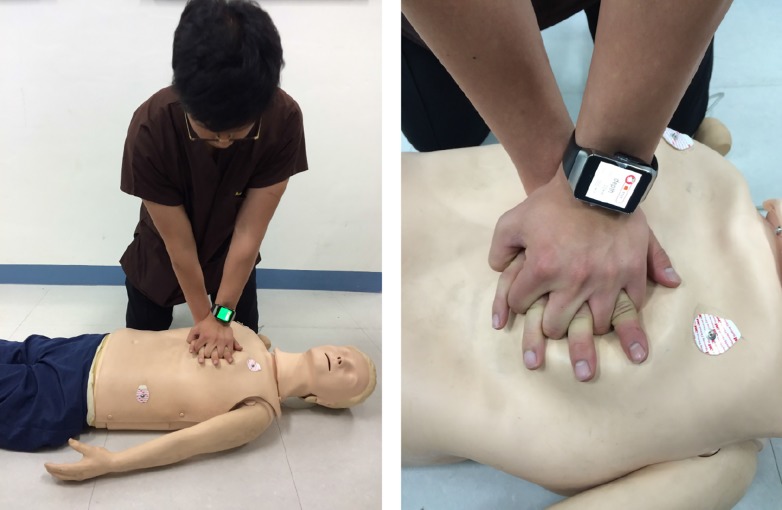
Chest compressions using a smartwatch-based feedback system.Participants, in a kneeling position adjacent to a manikin, compressed the chest of the manikin placed on a flat and firm surface. The smartwatch provided visual feedback and vibratory guidance regarding the chest compression depth and rate, respectively.